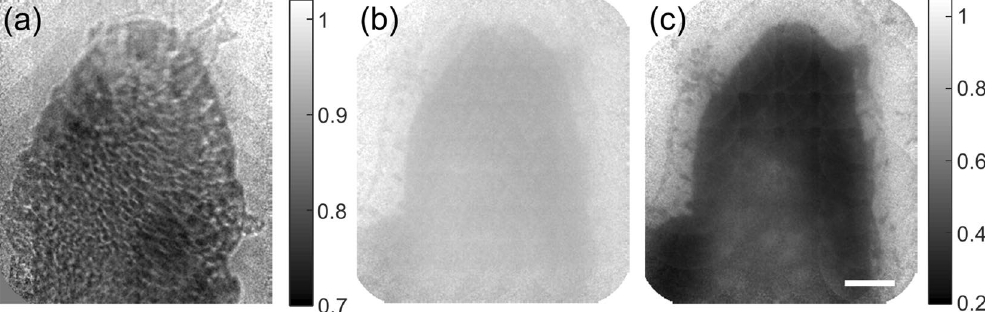
Figure 5. Ex vivo imaging of a small villus of a rat intestine. ( a ) WIWD in oil, ( b ) WIWD in air, and ( c ) SIWD in air. Scale bar: 50 μ m. For ( b ) and ( c ), the background intensity was normalized, and the color scales are the same. Color bars: normalized